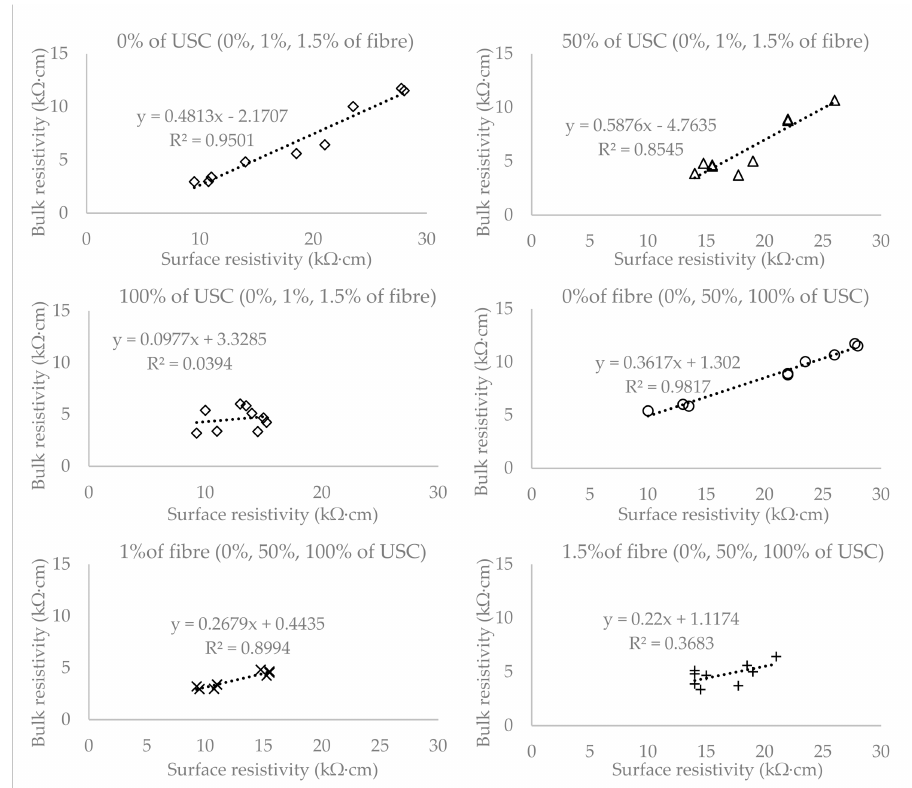
Figure 9. Correlation of surface and bulk resistivity on the plate specimens with coe ffi cient of determination on di ff erent groups according to the loading and the amount